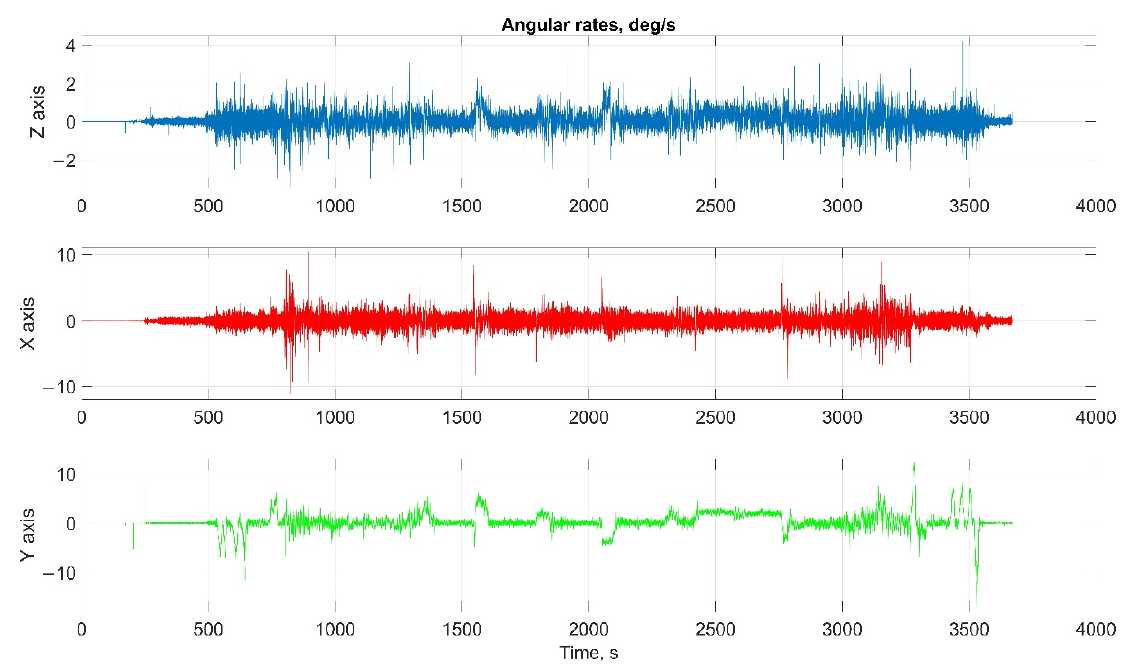
Figure 17. The angular rates in the projections onto body frame in helicopter test (X, lateral axis; Y, longitudinal axis; and Z, completes the right-handed system, up axis when OXY is horizontal plane).